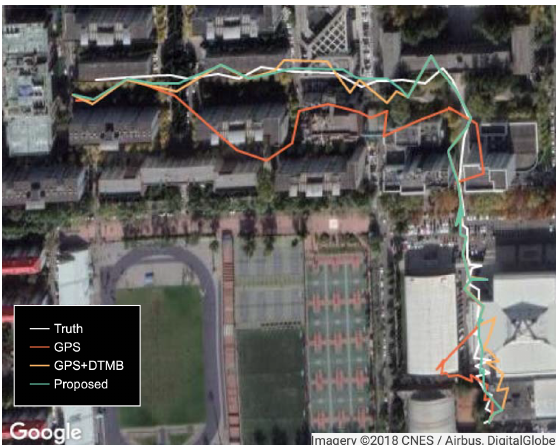
Figure 12. Trajectories generated from true positions and positioning results at Site 1.